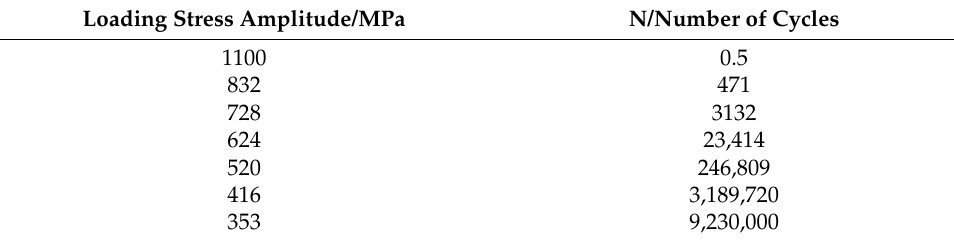
Figure 3. Test machine. Table 2. Fatigue test